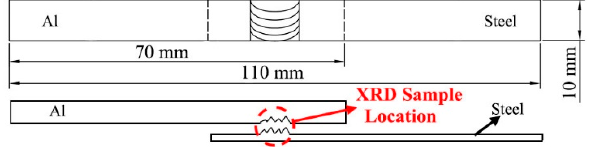
Figure 2. A schematic diagram of the tensile shear testing sample .